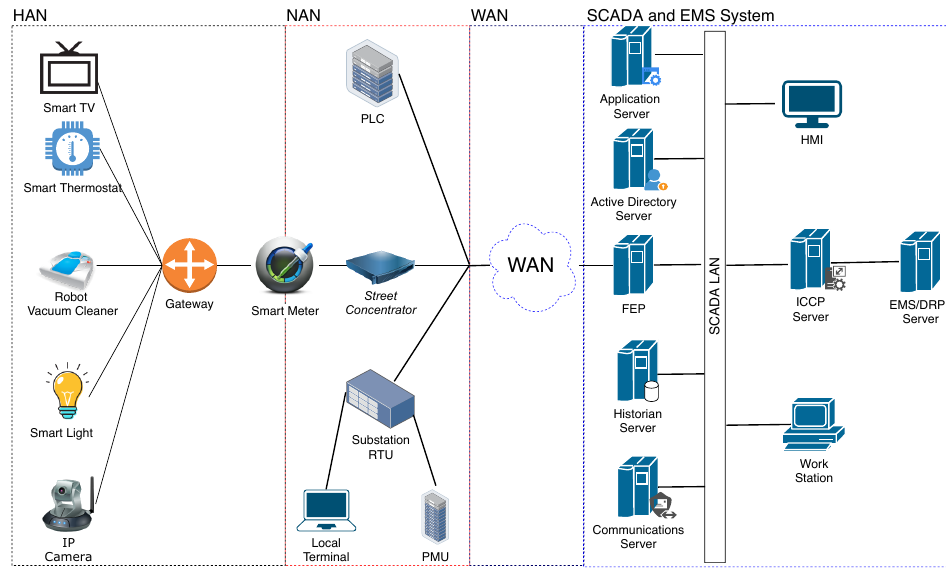
Figure 4. An example of the smart grid simplified network model with a